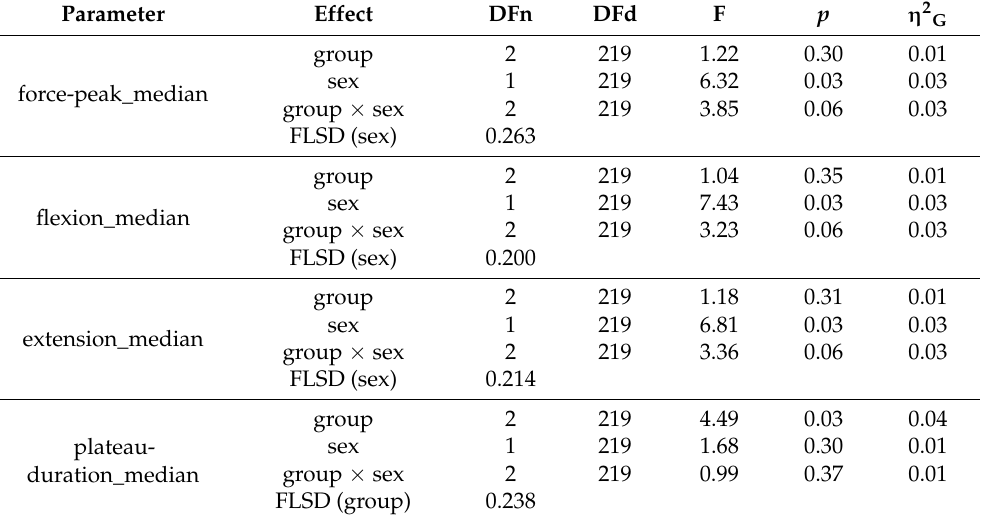
Table 3. ANOVA results for the self-selected pace condition. Only parameters with significant multiple